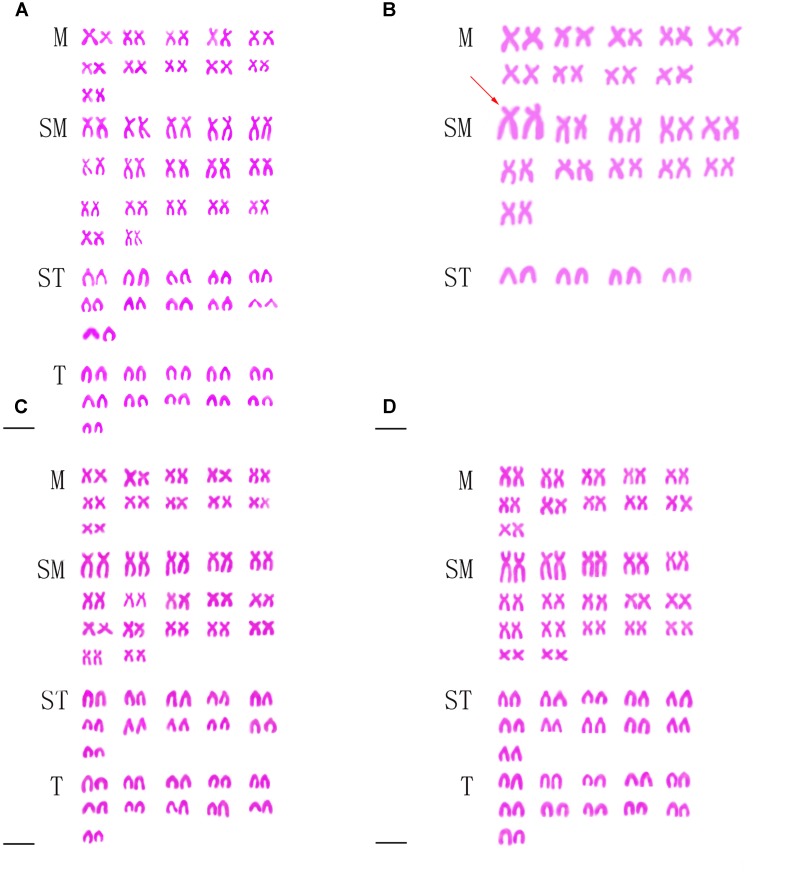
Karyotypes of KOC, BSB, RCC-L, and GF-L. (A) The karyotype of KOC is 22m + 34sm + 22st + 22t. (B) The karyotype of BSB is 18m + 22sm + 8st. (C) The karyotype of RCC-L is 22m + 34sm + 22st + 22t. (D) The karyotype of GF-L is 22m + 34sm + 22st + 22t. Bar = 3 μm. The red arrow indicates the two largest submetacentric chromosomes.